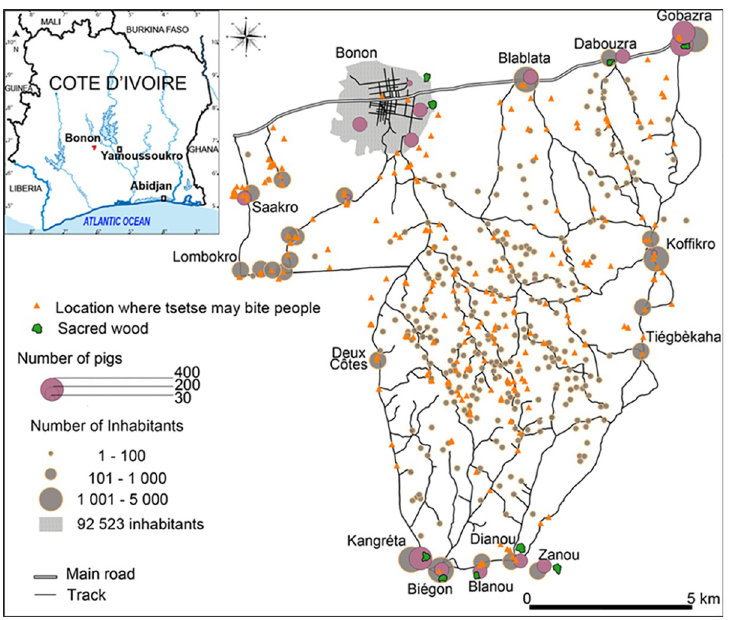
Fig 1. Location of the study area, settlement and sites where tsetse-human contact is relatively high.